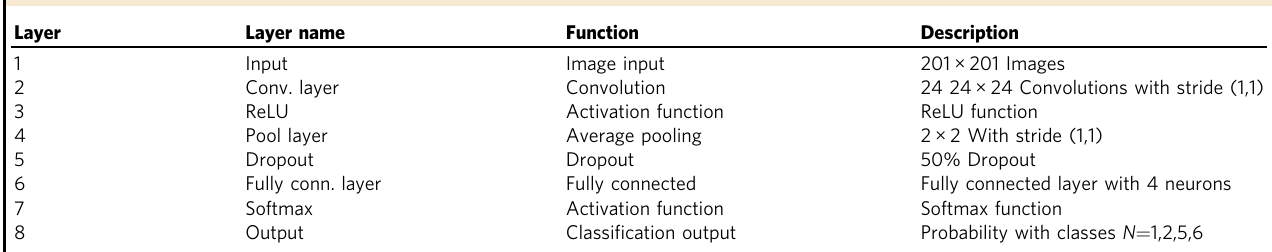
Table 1 Network architecture and parameters used in this